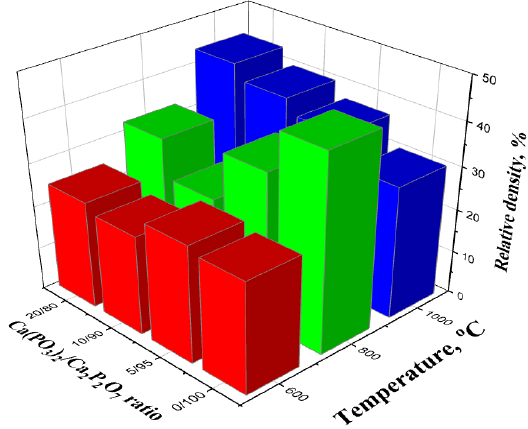
Figure 9. The relative density of samples with a weight ratio of: Ca(PO 3 ) 2 /Ca 2 P 2 O 7 = 0/100; Ca(PO 3 ) 2 /Ca 2 P 2 O 7 = 5/95; Ca(PO 3 ) 2 /Ca 2 P 2 O 7 = 10/90; Ca(PO 3 ) 2 /Ca 2 P 2 O 7 = 20/80 annealed in the temperature range of 600–1000 ◦ C.